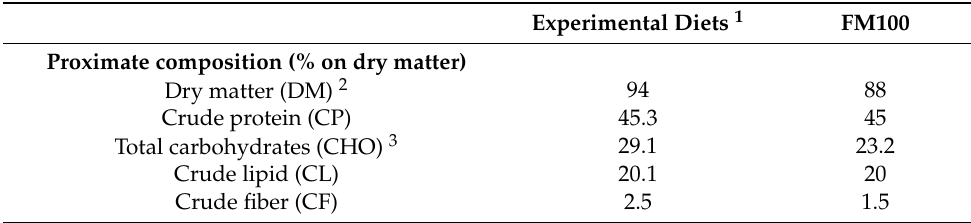
Table 2. Proximate composition of experimental